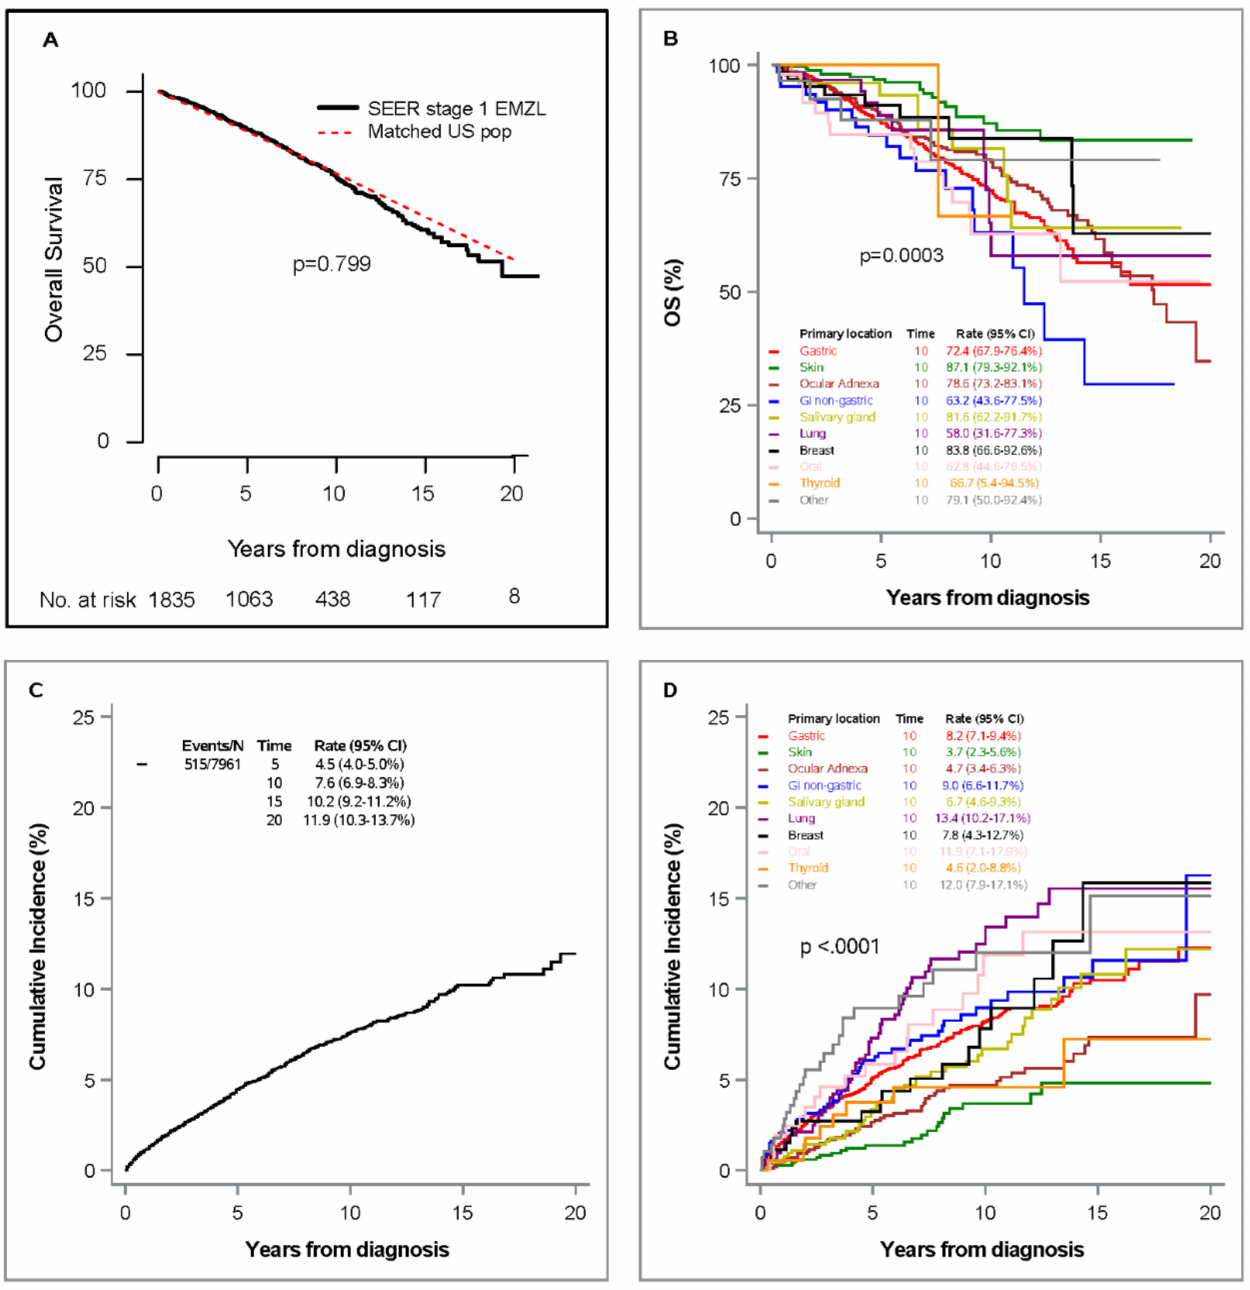
Figure 3. Overall survival in patients with stage I extranodal marginal zone lymphoma treated with radiation only ( n = 1835) versus age-, sex-, and calendar-matched U.S. population cohort ( A ); overall survival in patients with stage I EMZL treated with radiation only ( n = 1835) by primary location ( B ); and cumulative incidence rate of lymphoma-specific death in stage I EMZL overall ( C ) and by primary location ( D ). Tick marks for censored observations not shown given the large number of